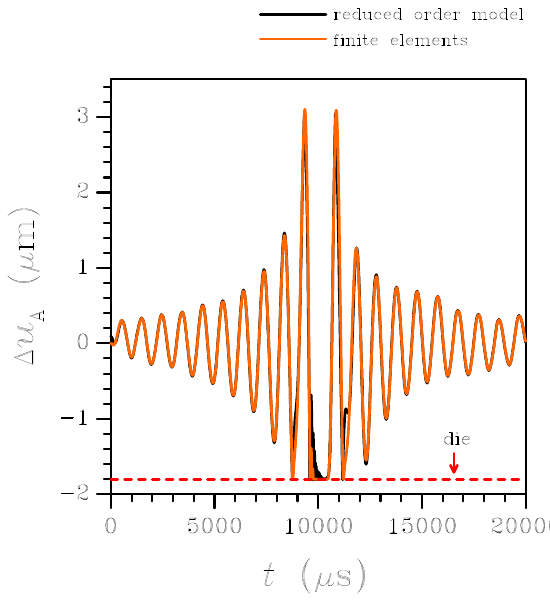
Figure 4. Low- g test: time evolution of the relative displacement ∆ u (see Figure 1). Comparison between FE and ROM